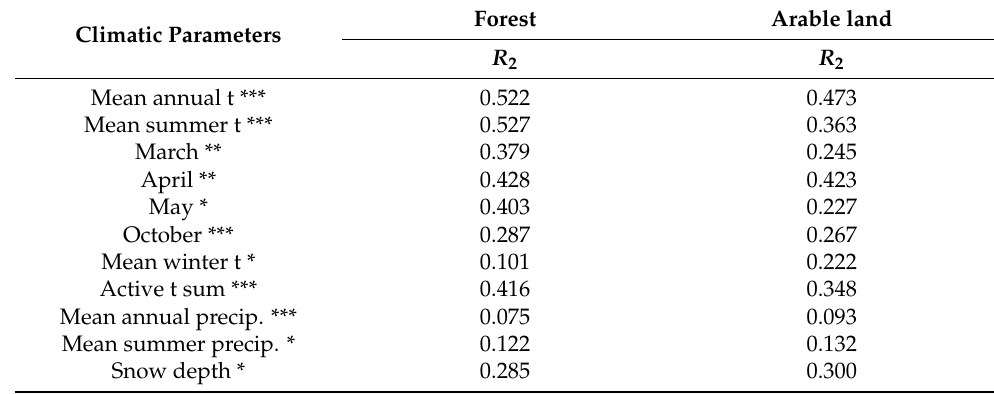
Table 2. Correlation coefficients ( R 2 ) and t-test results of ALD and climatic parameters. Difference between periods B and